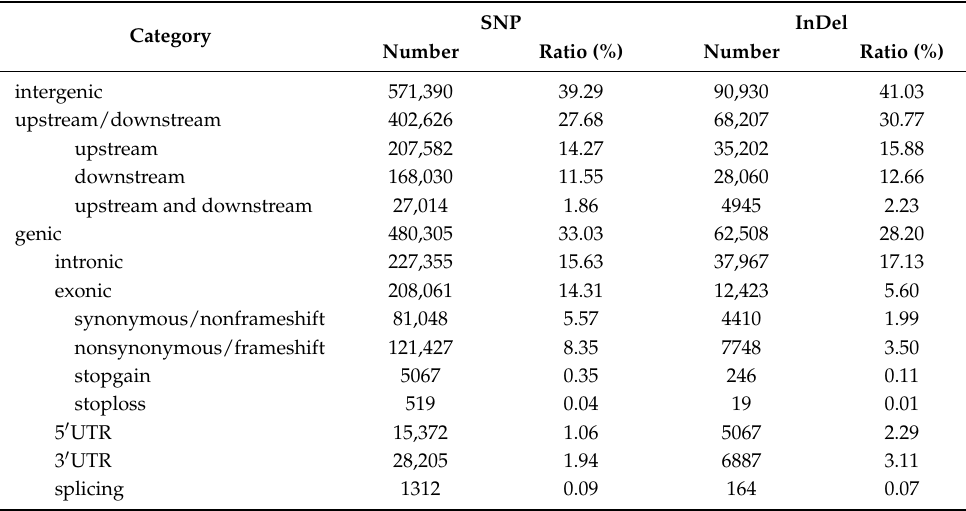
Figure 1. Distribution of variations in the 12 chromosomes in DXWR. Table 2. The annotations of variation sites in